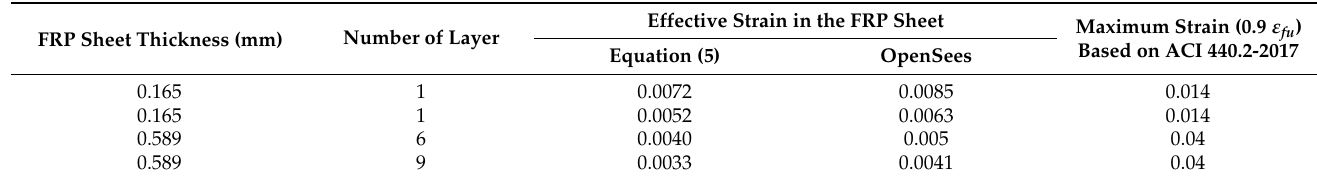
Table 12. Maximum effective FRP strain in Flange-bonding